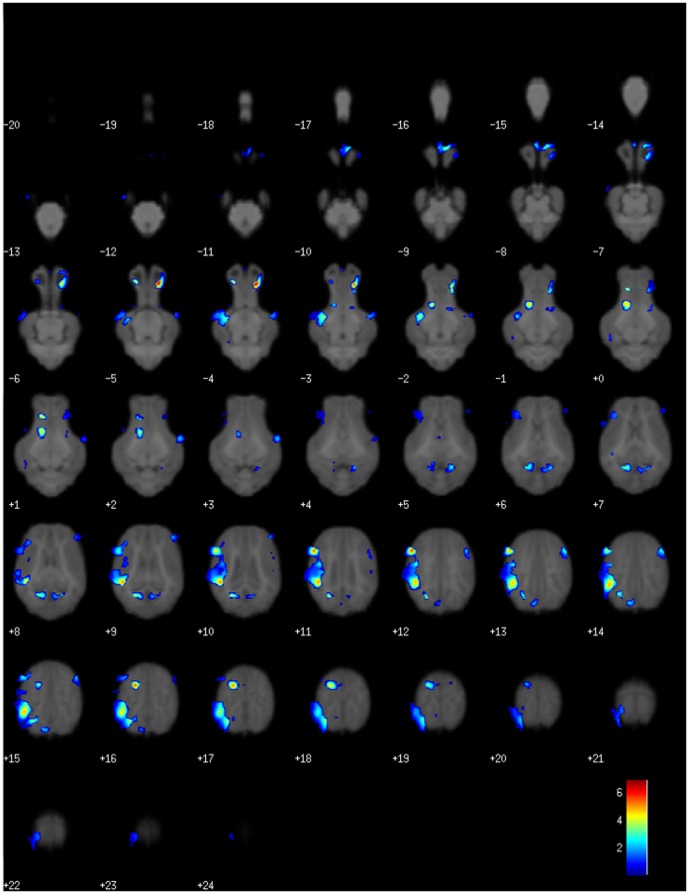
Voxel-based morphometry analysis using DARTEL defined 9 areas where SGA piglets had less white matter than AGA piglets.These areas were in the olfactory bulb, left and right cortex, and internal capsule. The color bar indicates the pseudo-t statistic indicating level of significance.